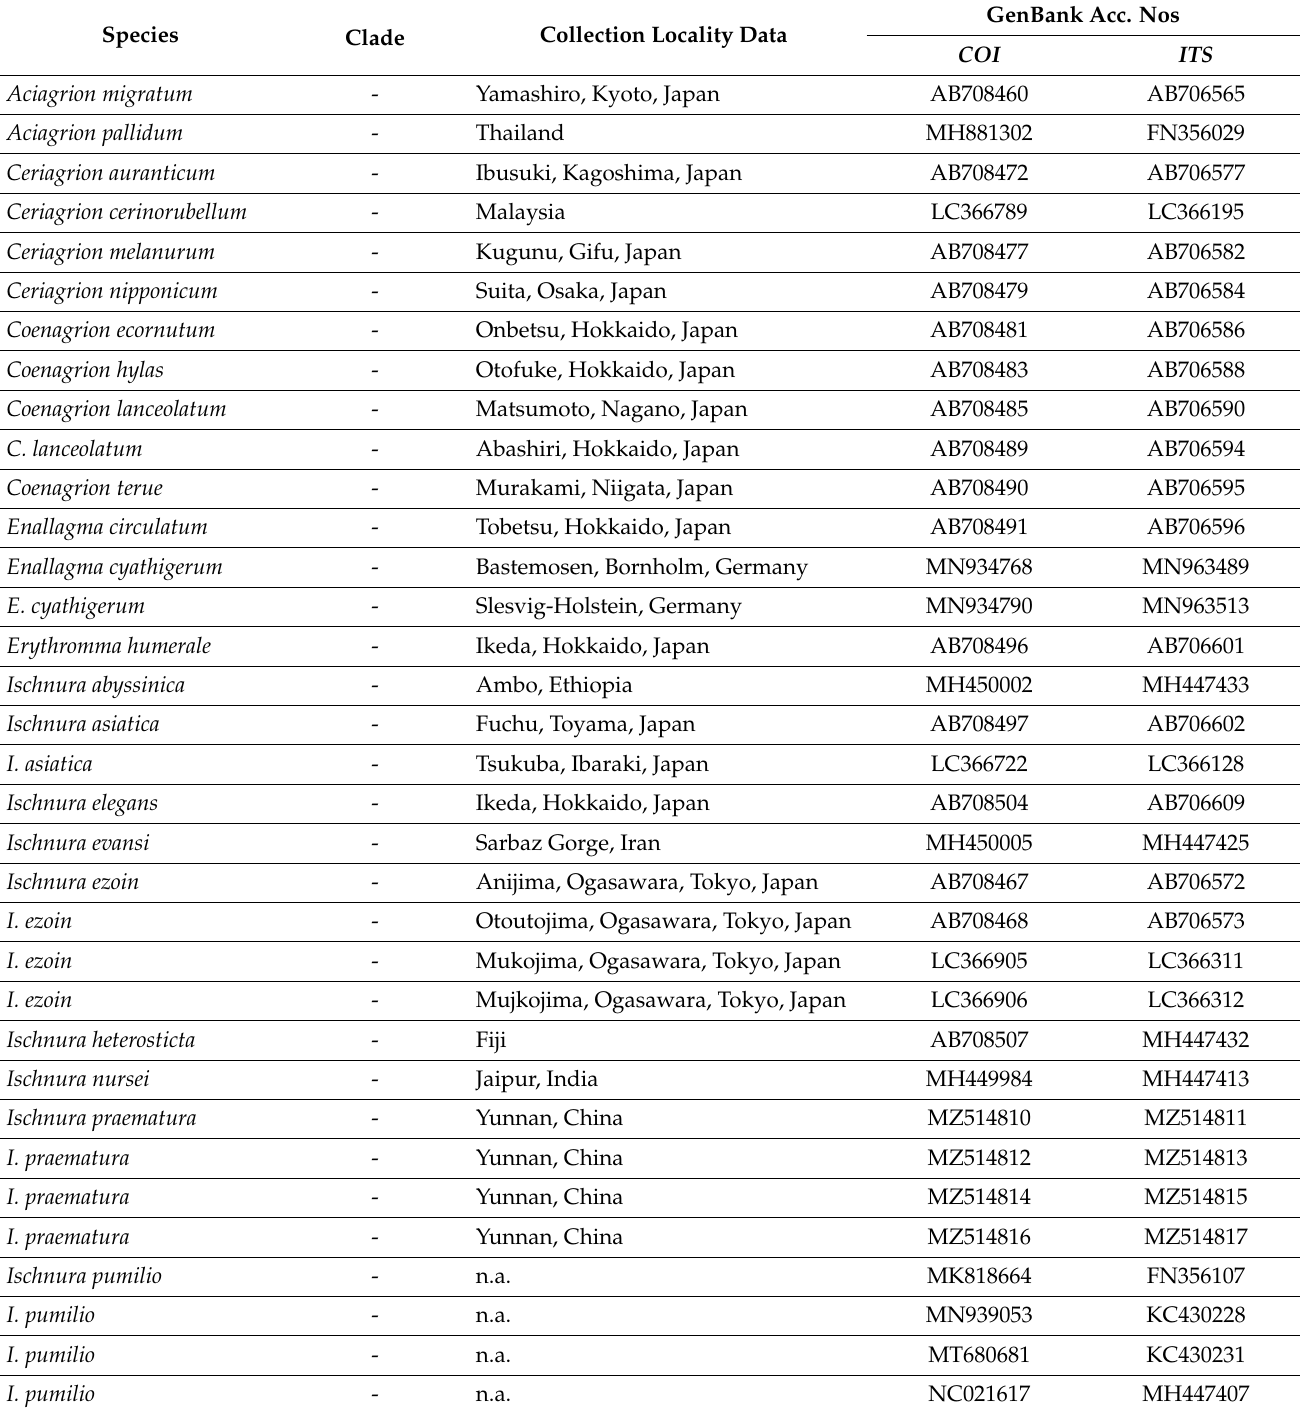
Table A1. Accession numbers for the COI and ITS sequences selected for genetic analyses after quality control as described in Appendix A. For Ischnura aurora , I. delicata and I. rubilio , we list the information on the clade to which each individual belongs according to the genetic analyses. Highlighted in bold are the individuals that fall outside their expected clades according to the genetic and ASAP analyses (see main text and Figure